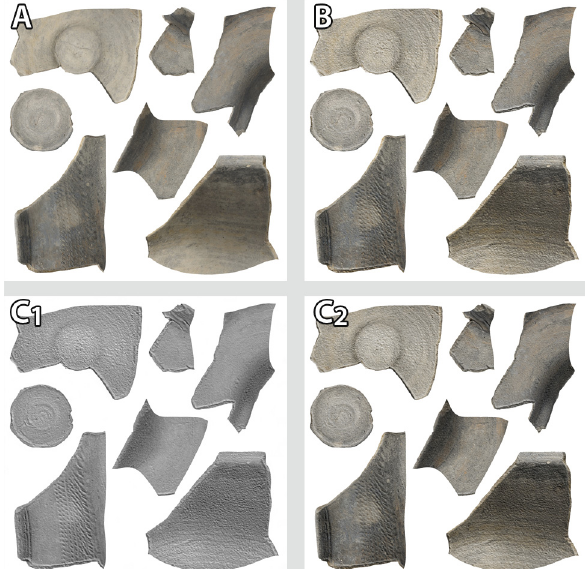
Figure 9. The default diffuse photographic texture (A) is turned into a morphology-enhanced version using the Overlay blending method (B) or using a combination of the Multi-Scale Laplacian Pyramid Transform and Sparse Representation image fusion (C1) followed by an Overlay blending step